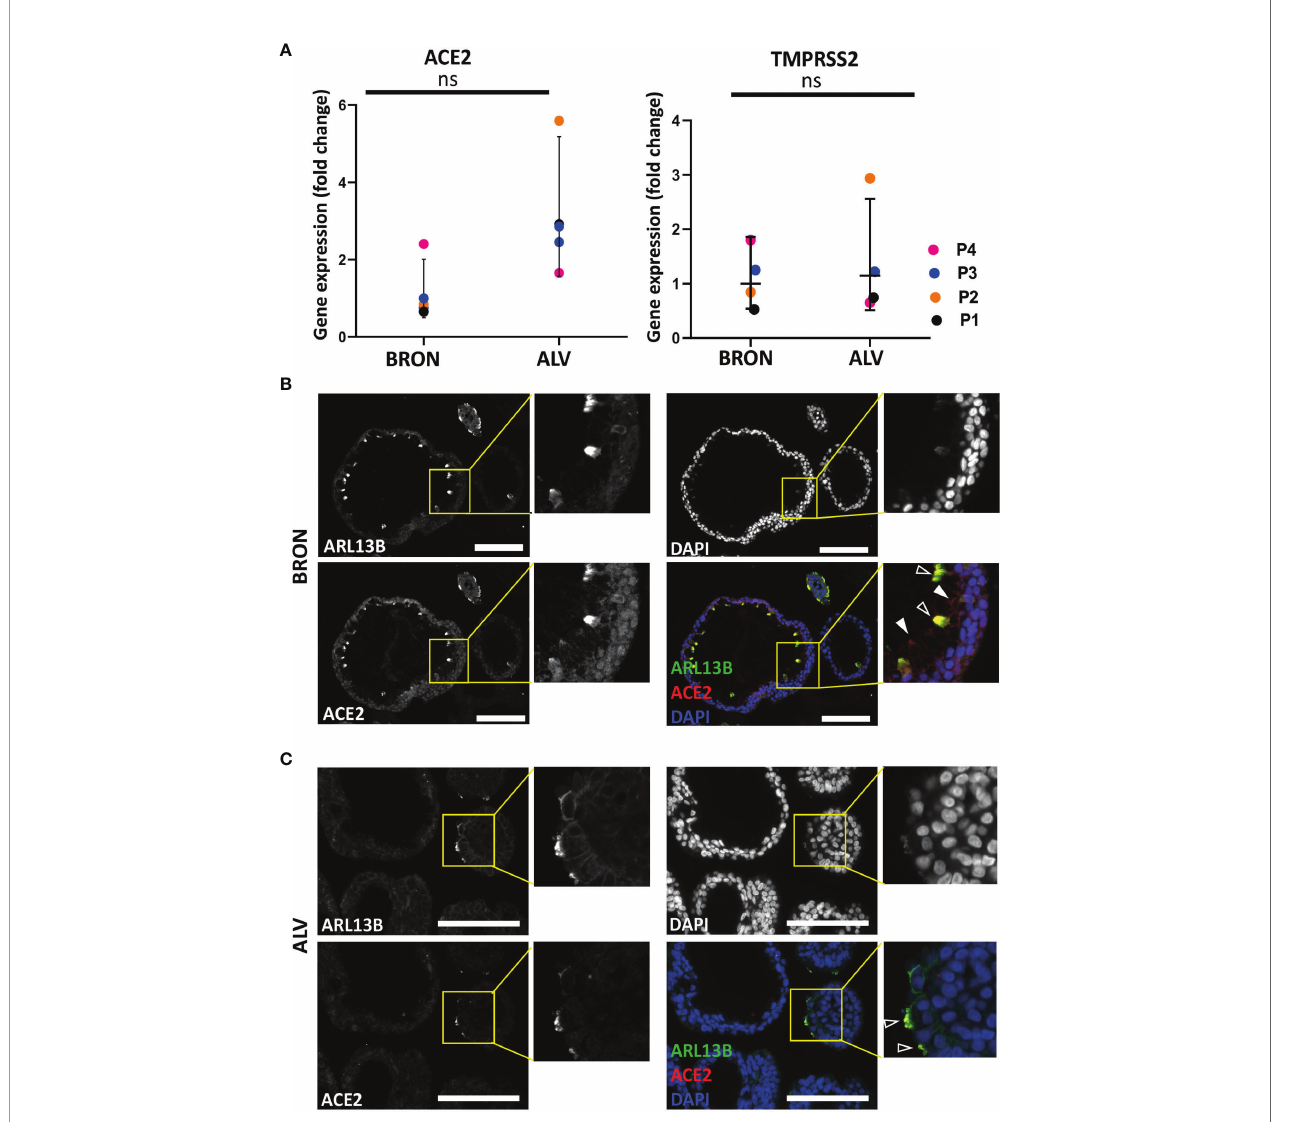
FIGURE 6 | Expression of SARS-CoV-2 entry factors in BRON and ALV organoids. (A) ACE2 (left) and TMPRSS2 (right) expression is detected in patient L2 organoids of bronchiolar (BRON) and alveolar (ALV) differentiation from passage 1-4. Relative quanti fi cation was performed using the Livac method and alveolar organoids are normalized to the average delta Ct of bronchiolar organoids. The mean value of three technical replicates for each passage are shown as individual data points. GraphPadPrism v9 was used to calculate and display the geometric mean and 90% con fi dence interval of the biological replicates (passages). Statistics were performed on the delta Ct values using the Mann-Whitney test. No statistically signi fi cant differences were observed in the median deltaCt values of ACE2 between BRON and ALV cultures. (B) Immuno fl uorescent staining of formalin fi xed paraf fi n embedded (FFPE) sections of bronchiolar (BRON) organoids (representative images from patient L2 passage 2), display co-staining of the cilia marker (ARL13B) and the SARS-CoV-2 receptor ACE2 (transparent arrowheads). ACE2 staining alone (white arrowheads). Scale bar equals 100 µm. (C) Immuno fl uorescent staining of formalin fi xed paraf fi n embedded (FFPE) sections of alveolar (ALV) organoids (representative images from patient L2 passage 2), display co-staining of the cilia marker (ARL13B) and the SARS-CoV-2 receptor ACE2 (transparent arrowheads). Scale bar equals 100 µm. ns, not signi fi